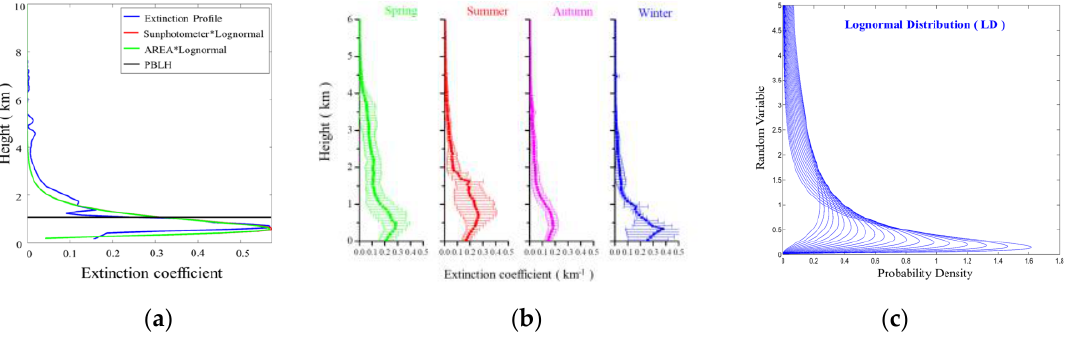
Figure 1. ( a ) Aerosol extinction profile observed from the Micro Pulse LiDAR network (MPLNET) NCU_Taiwan site on May 9, 2009 (blue line) and manual fitting with a log-normal distribution (green line). The red line shows the sun photometer aerosol optical depth (AOD) integrated profile, and the black line indicates the planetary boundary layer height (PBLH); ( b ) the seasonal profiles of aerosol extinction at the MPLNET NCU_Taiwan site in mean value (bold lines) with standard deviation (horizontal bars) from 2006 to 2008; ( c ) the log-normal distributions with di ff erent logarithmic standard deviations after being rotated 90 degrees